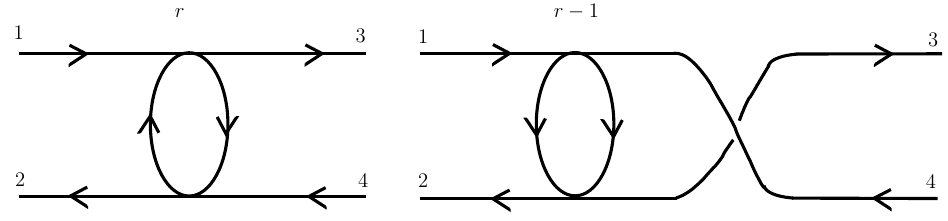
Figure 9 . Ladder diagrams in a theory with (1) symmetry and (cid:30) r (cid:30) r couplings (sketched here U for r = 2), either (a) without charge exchange or (b) with charge exchange. The two diagrams have relative combinatoric factors r and r 1, respectively, from counting Wick contractions. In the (cid:0) symmetric channel the resulting contribution is a factor of r +( r 1) = b q 1, but in the antisymmetric (cid:0) (cid:0) channel, one gets instead r ( r 1) = 1. So the kernel is smaller in the antisymmetric channel by (cid:0) (cid:0) a factor of b q (cid:0)